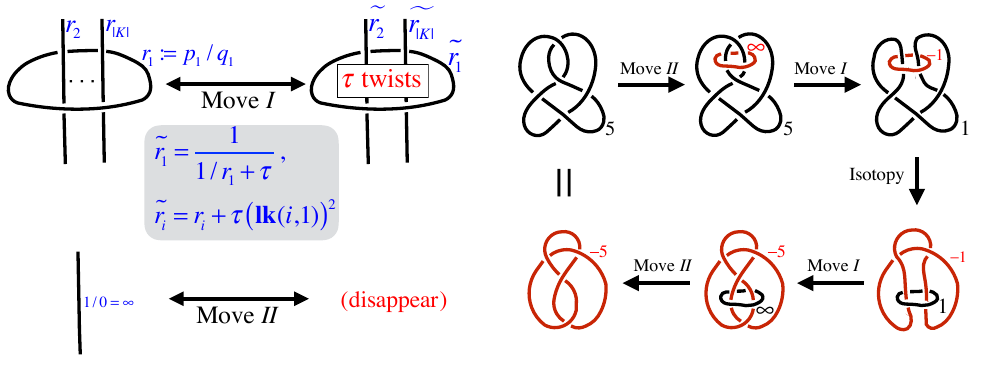
Figure 6 . Left : basic moves in rational surgery calculus [41]. The rational number r i next to i -th component of link K represent Dehn (cid:12)lling slope and lk ( i; 1) denotes the linking number between i -th component and 1st component. Right: a sequence of basic moves showing ( S 3 n 4 1 ) (cid:0) 5 (cid:22) + (cid:21) = ( S 3 n 5 2 ) 5 (cid:22) + (cid:21)